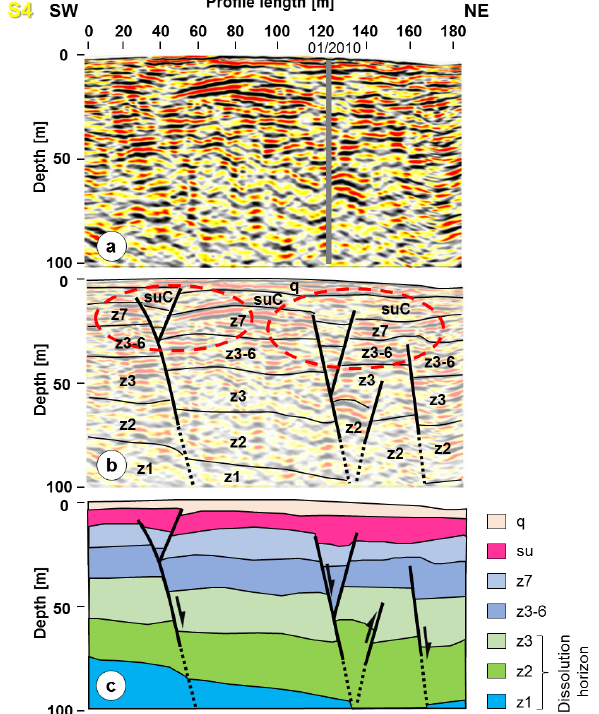
Figure 9. Uninterpreted reflection-seismic profile S4 (a) with stratigraphy derived from the 01/2010 borehole (b) and with inter- pretation (c) . The stratigraphic units are explained in Fig. 3. The profile was surveyed north of the sinkhole, parallel to S1(1). The normal faults seen in S1 were also identified in S4, while two al- most bowl-shaped structures (red dashed circles) are visible in the south-west and the north-east.